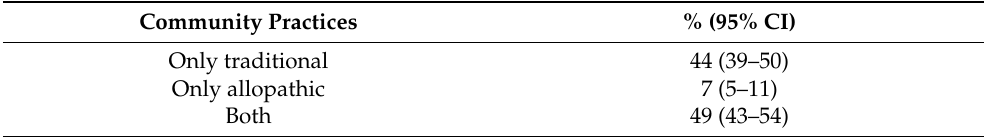
Table 2. Community practices to treat snakebite by category (N = 297).